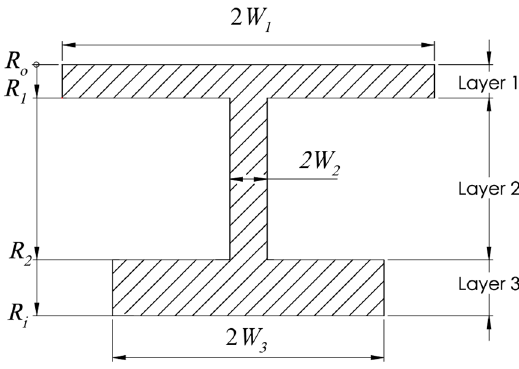
Figure 5. Divided three sections of the pulley structure . Figure 5. 11TDivided three sections of the pulley 11T